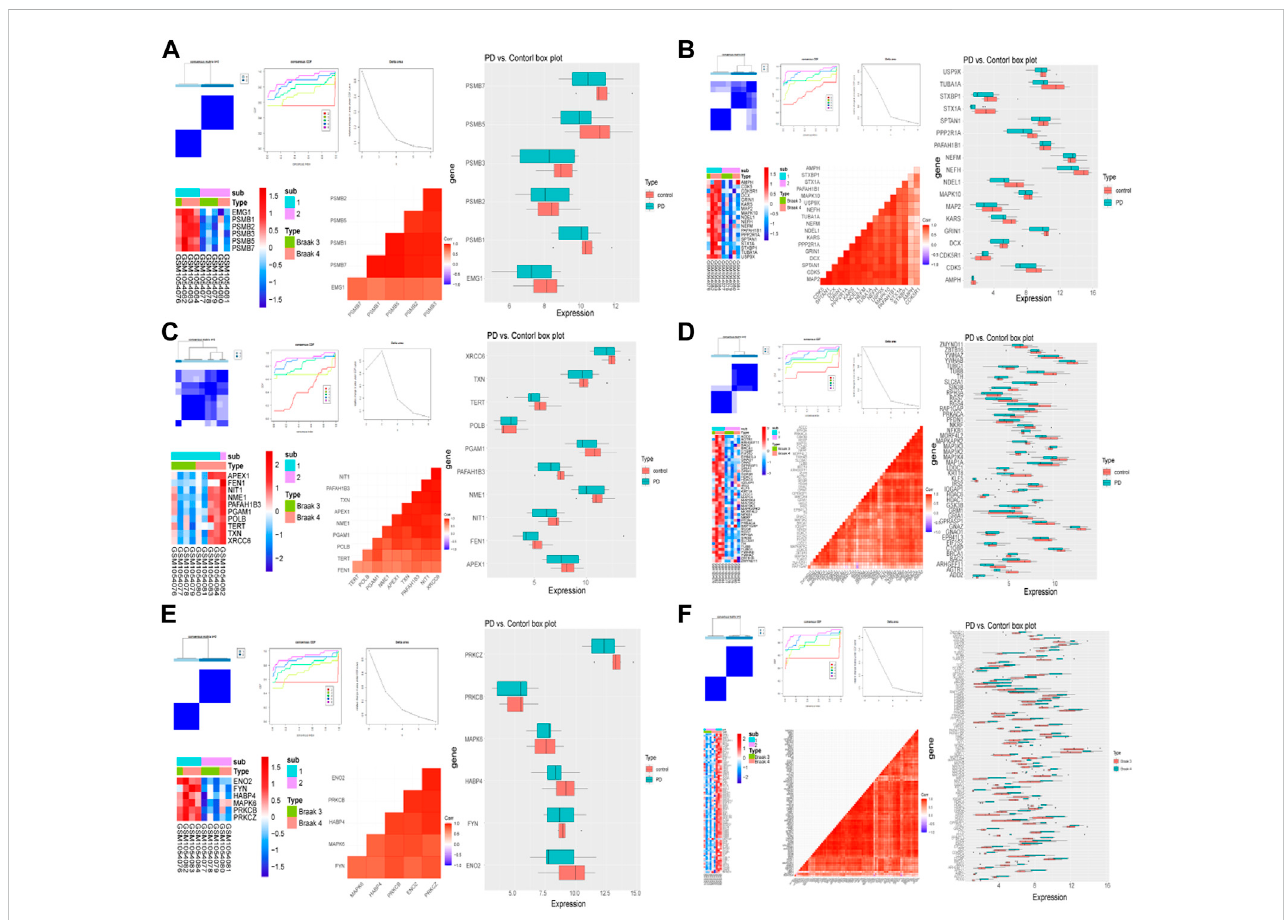
FIGURE 4 Validation ofthe classi fi cationpower by GSE20292 data set. The consensus clusterheatmap,cumulativedistribution function (CDF)plot, delta areaplot, geneexpressionheatmap,genecorrelationheatmap,andgeneexpressionboxplotofsixmodulesincludingmodule1 (A) ,module2 (B) ,module3 (C) ,module 4 (D) , module 5 (E) , and common genes (F)